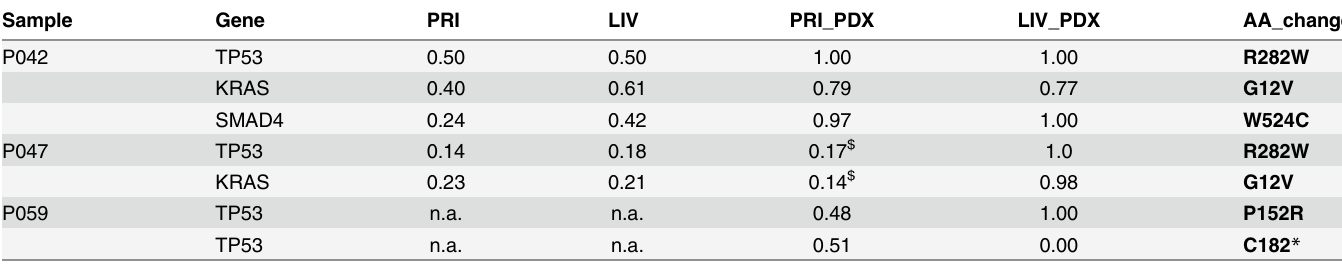
Table 4. Somatic SNVs affecting key cancer genes.